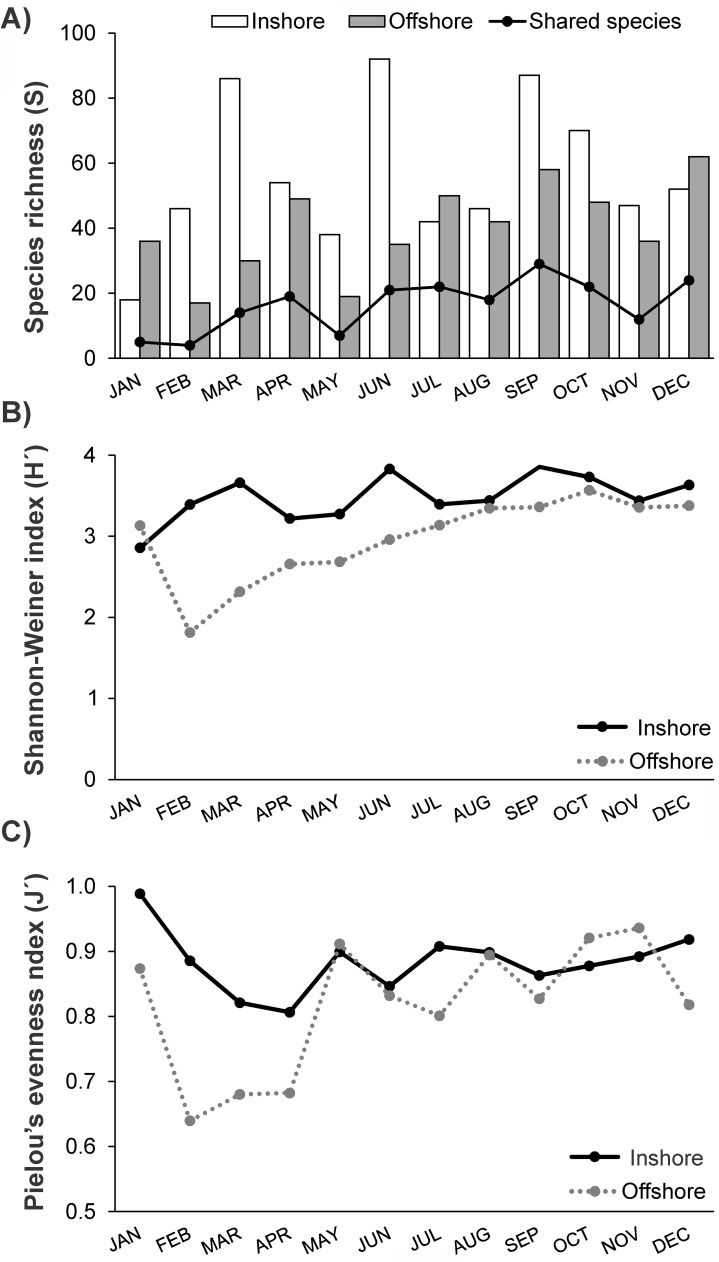
Diversity of larval fish.Species richness (A), Shannon-Weinner (B) and Pielou’s (C) diversity indices of encountered taxa in the samples of both stations.